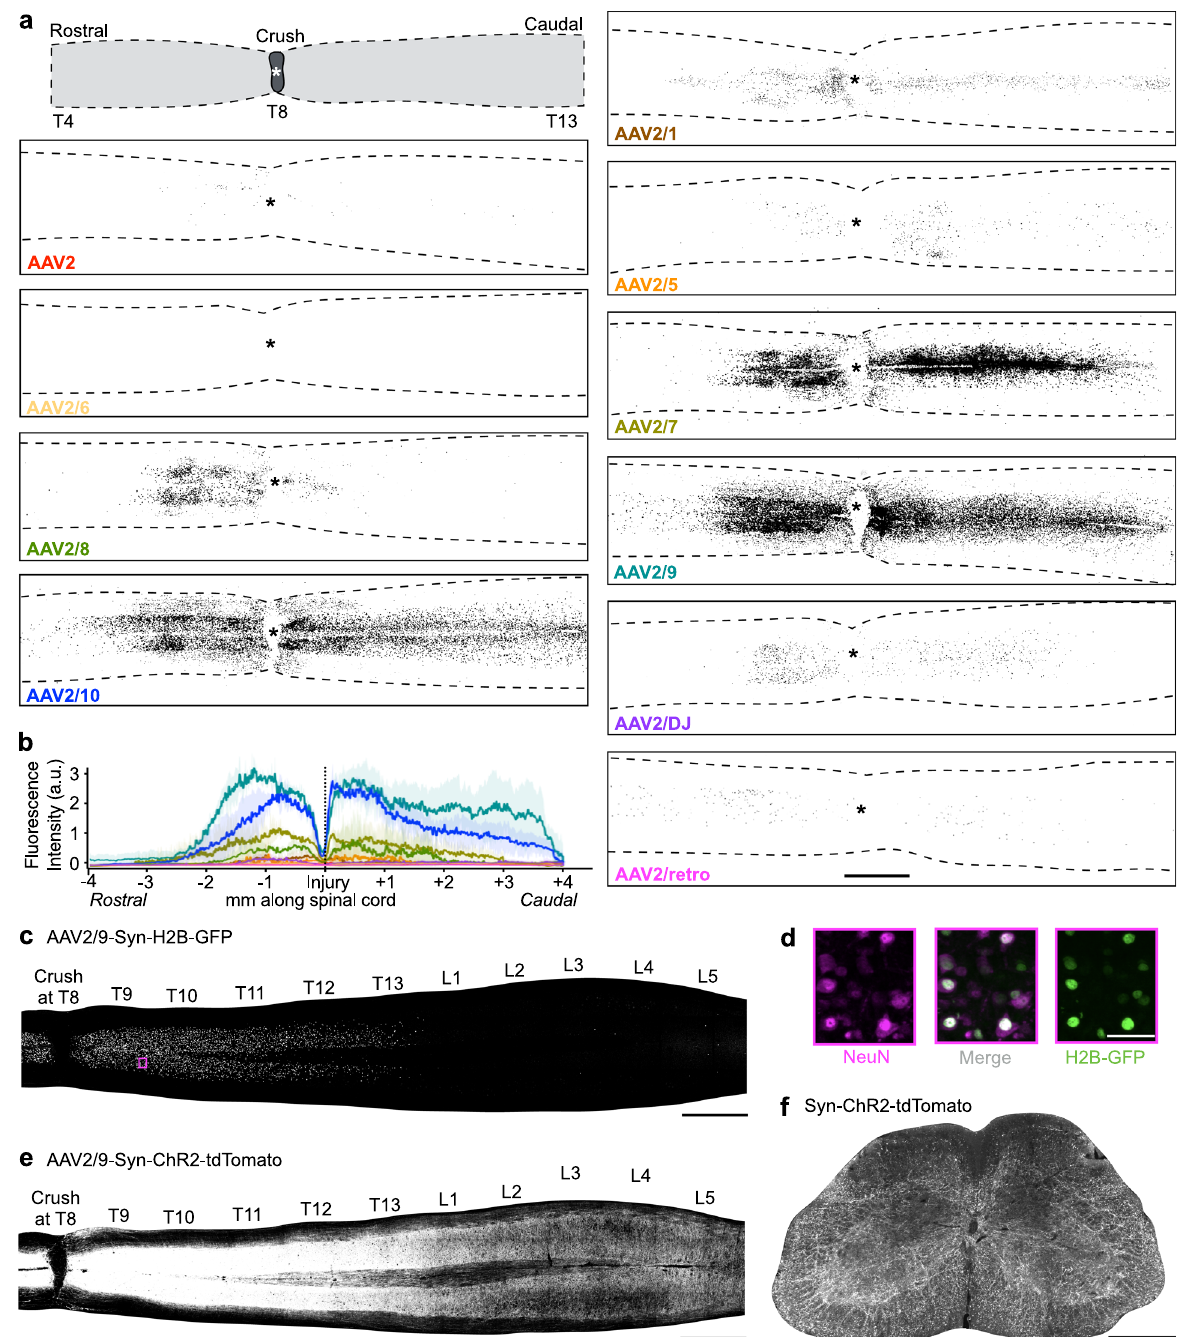
Fig. 1 A screen for AAV serotypes that are able to cross blood spinal cord barrier and transduce cells around the lesion after spinal cord crush. a Representative images of longitudinal sections of the thoracic spinal cord show transduced cells after tail vein injection of different serotypes of AAVs expressing CAG-H2B-GFP at 3 h after T8 crush injury. Similar distributions were observed in all of 3 analysed mice for each AAV serotype. Scale bar: 1 mm. An asterisk represents lesion centre. b Quanti fi cation of GFP expression along the longitudinal axis. Mean ± SD are indicated by line and shadow with corresponding colours. a.u.: arbitrary unit. The fl uorescence intensities were normalized to that in AAV2/9 ( n = 3 mice for each AAV serotype, 5 sections per mouse). c Representative image showing the expression of H2B-GFP (cell bodies only) in different spinal levels. Similar distributions were observed in all of 3 analysed mice. Scale bar: 1 mm. d Magni fi cation of the highlighted area one spinal segment away from the lesion (purple box in ( c )), indicating co-localization of H2B-GFP and NeuN. Scale bar: 100 µ m. e Representative image showing the expression of ChR2-tdTomato (cell bodies and axons) in different spinal levels. Similar distributions were observed in all of 3 analysed mice. Scale bar: 1 mm. f Cross section of the lumbar spinal cord showing descending ChR2-tdTomato + axons from thoracic propriospinal neurons. Similar distributions were observed in all of 3 analysed mice. Scale bar: 500 µ m.